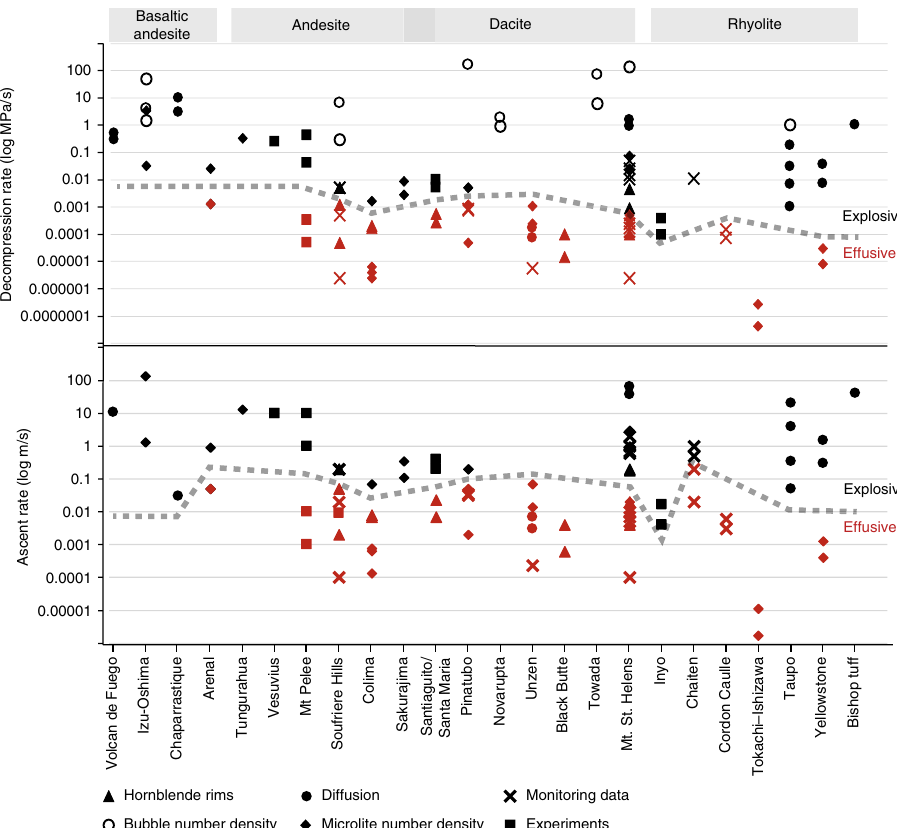
Fig. 5 Comparison of all syn-eruptive ascent rates estimates, from multiple volcanoes ranging from basaltic andesite to rhyolites (Supplementary data 1). This plot collects ascent and decompression rate data from a range of different techniques, including microlite crystallinity, bubble number density, experiments, hornblende rims, seismicity, extrusion rate and diffusion rates. Where decompression rates were not given, these were calculated from the ascent rates using an assumed lithostatic pressure gradient of 0.025MPa/m. Magma ascent and decompression rates are from the following sources, from left to right: Volcan de Fuego, Guatemala 187 ; Izu-Oshima, Japan 188,189 ; Chaparrastique volcano, El Salvador 190 ; Arenal, Costa Rica 191 ;